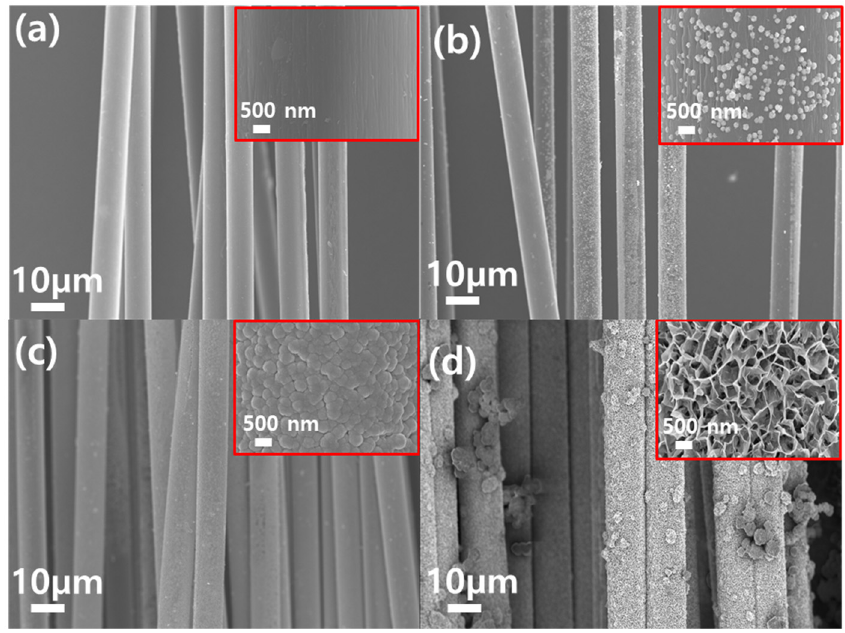
Figure 3. FE-SEM images of pure PICF ( a ), N10@PICF ( b ), N20@PICF ( c ), and CM/N20@PICF-6 ( d ), inset shows the higher magnified images.